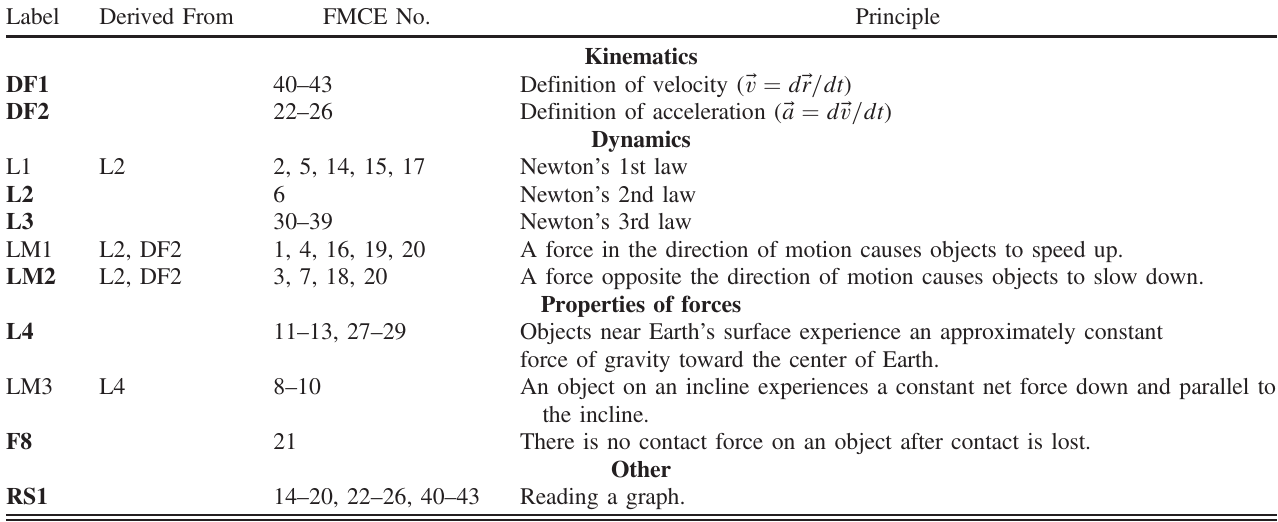
abbreviation for the type of principle and a number. The items with labels printed in bold are the principles included in the optimal constrained MIRT model. When possible, the principles are labeled consistently with study 1. Study 1